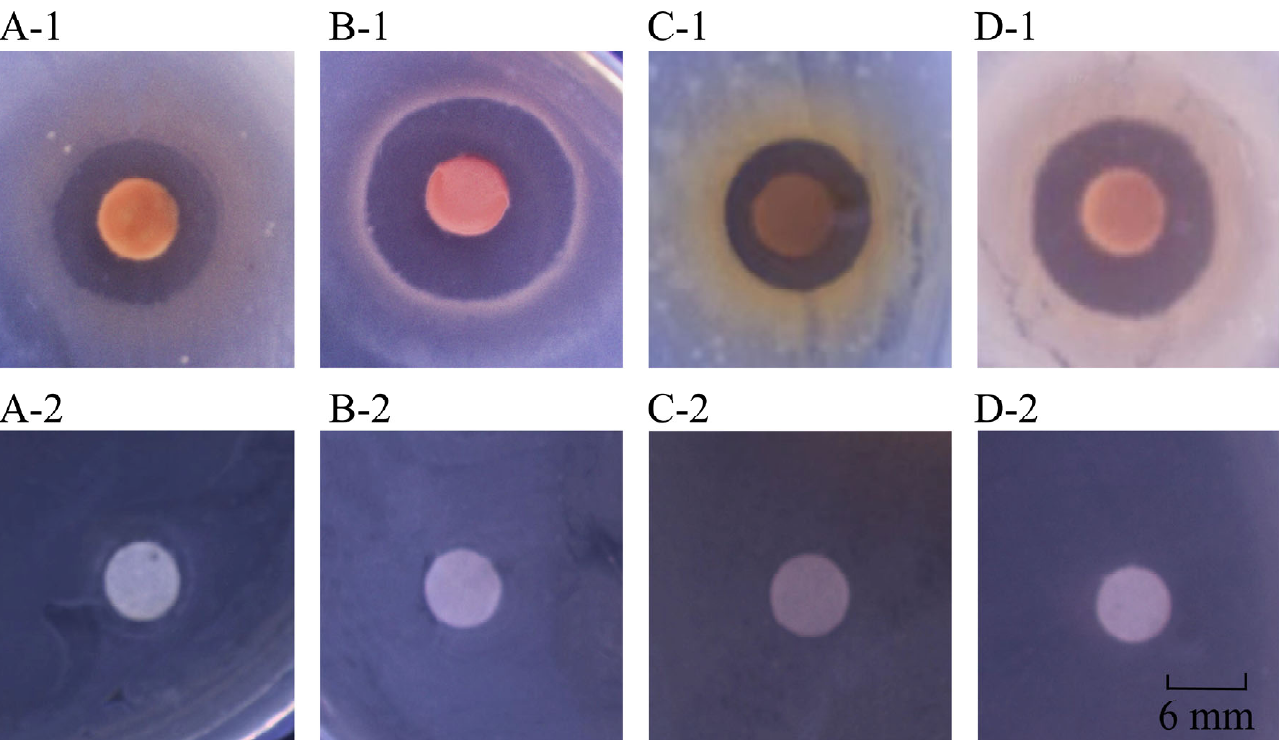
Figure 1. Inhibition activity of the methanol ‐ phase crude extract from C. communis Linn. ( A ‐ 1 – D ‐ 1 ) B. cereus A1 ‐ 1, E. faecali s C1 ‐ 1, S. aureus ATCC25923, and S. enterica subsp. enterica (ex Kauffmann and Edwards) Le Minor and Popoff serovar Vellore ATCC15611, respectively. ( A ‐ 2 – D ‐ 2 ) Corre ‐ sponding negative controls, respectively.